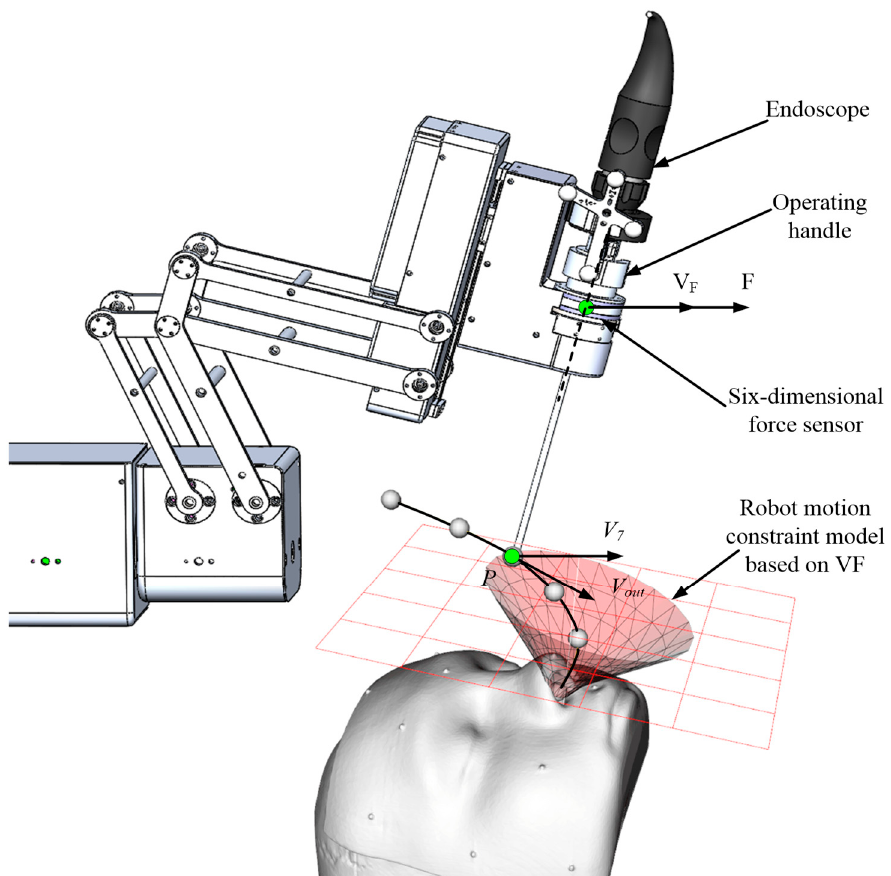
Figure 7. Schematic diagram of human–robot cooperative control based on VF.